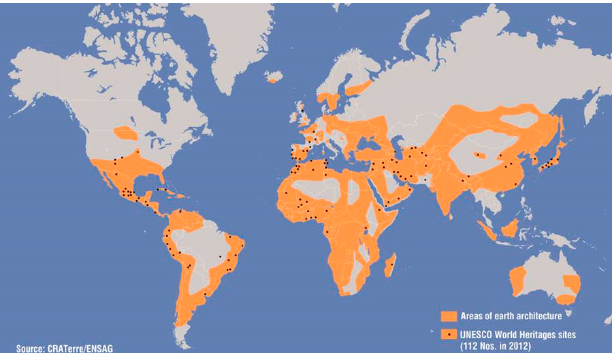
Figure 1. Earth construction areas of the world. Auroville Earth Institute, UNESCO chair earthen architecture. Building with Earth–Technique overview, 2012 [8].